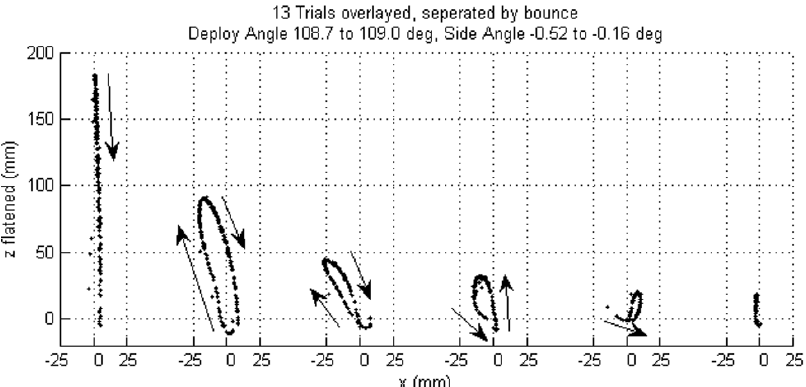
Fig. 13. With the same starting point, bounces would trace the same path. Paths are overlayed with each bounce shifted to the right, so that each bounce can be seen clearly.